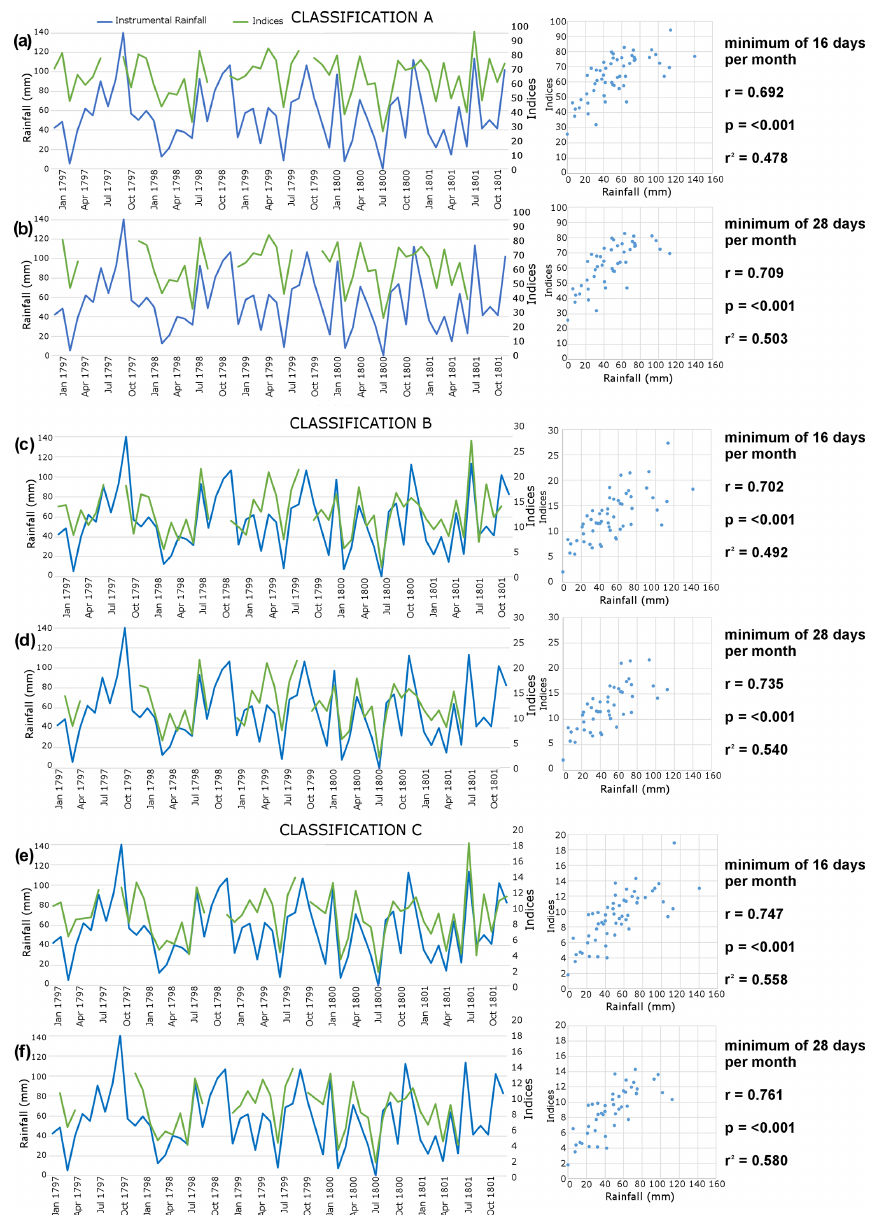
Figure 3. Statistical analysis of the three classification approaches A–C (green) using 16 (a, c, e) and 28 (b, d, f) day records respectively compared to instrumental rainfall at Kew